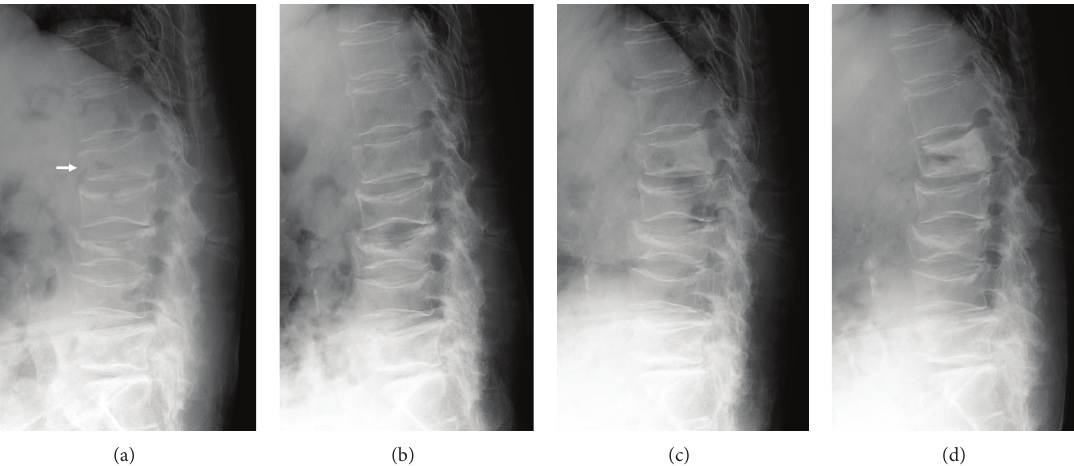
Figure 1: Plain lateral X-rays of the lumbar spine. (a) At the initial visit, the L1 vertebra shows a wedge-shaped deformity with a vertebral kyphosis angle (VKA) of 20 ∘ and a small intravertebral cleft (arrow). (b) At 2 weeks after injury, VKA of L1 is decreased (6 ∘ ) compared to baseline, showing unstable vertebra. (c) At 2 months after injury, VKA of L1 is 8 ∘ with consolidation of the posterior wall. (d) At 7 months after injury, VKA of L1 is unchanged (8 ∘ ) in the corrected position, although anterior intravertebral cleft